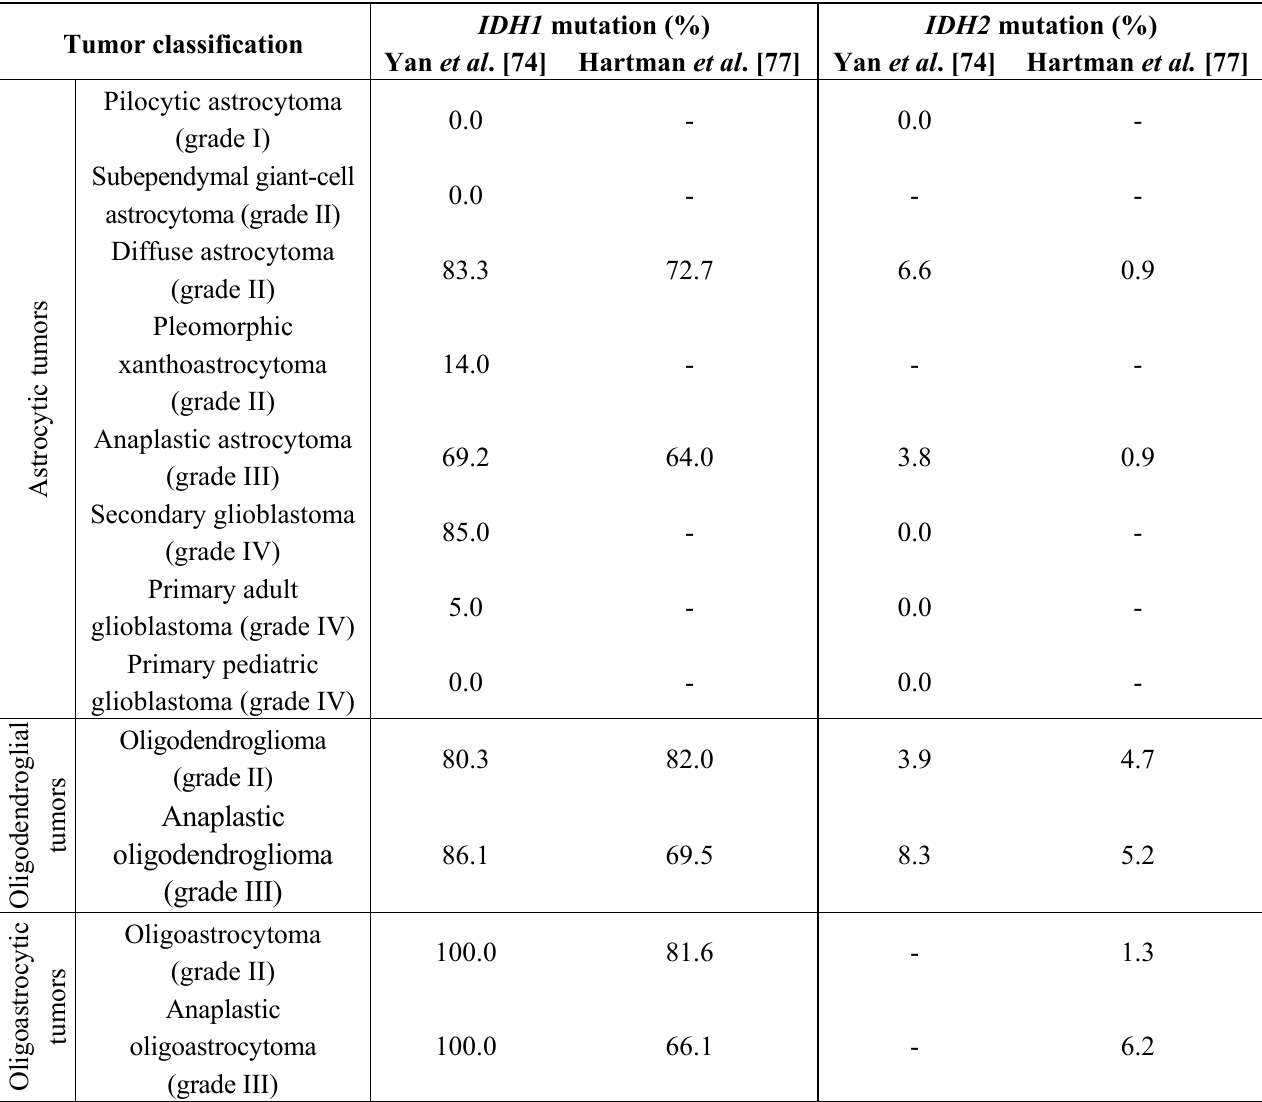
Table 2. Frequency of IDH1/2 mutation in